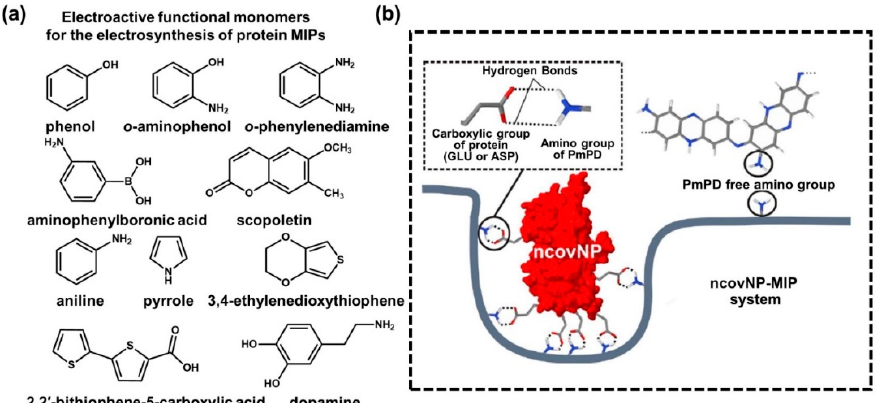
Figure 3. ( a ) Representative electroactive monomers used for implementation of the MIP-based biorecognition system; chemical structures of each functional monomer are listed as follows: phenol, o-aminophenol, o-phenylenediamine, aminophenylboronic acid, scopoletin, aniline, pyrrole, 3,4- ethylenedioxythiophene, 2,2 ′ -bithiophene-5-carboxylic acid and dopamine. ( b ) Schematic illustration of the ncovNP–MIP system to form multiple non-covalent bonds between ncovNP and cavity. Reproduced with permission from [80]. Copyright Elsevier, 2020.